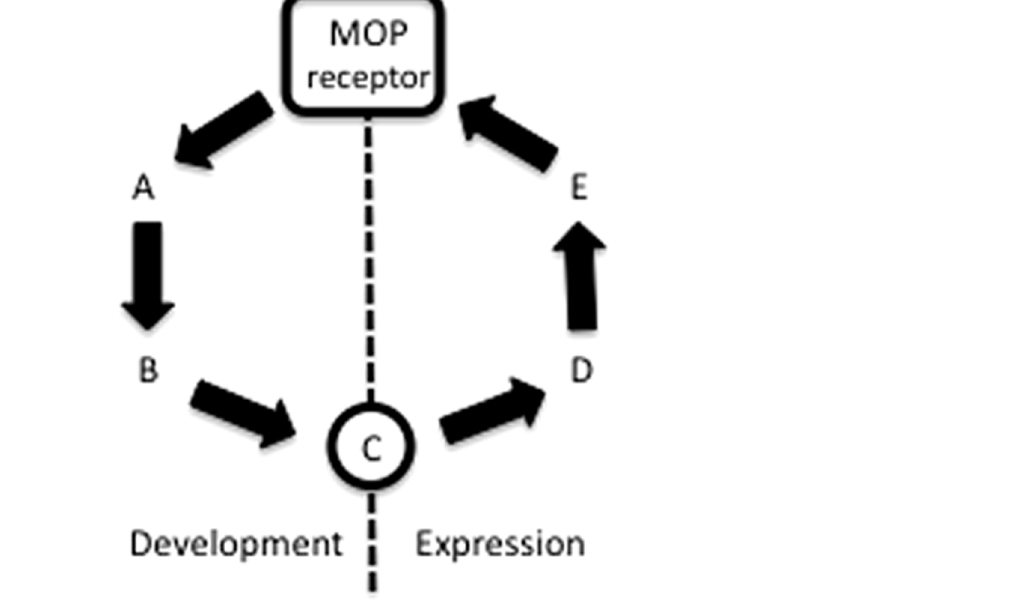
Fig. 1. Model of MOPr signaling showing that distinct molecules contribute to the development and expression of opioid tolerance. Tolerance could be caused by a change anywhere along the signaling pathway. If this change occurs at point C in the model, then repeated co-administration of an opioid with a drug that blocks signaling at points A, B, or C will prevent the development of tolerance. Once tolerance has developed, blocking signaling at points A or B will have no effect on the expression of tolerance because signaling at point C is already altered. However, a drug that blocks the enhanced signaling from points C, D, or E will block the expression of